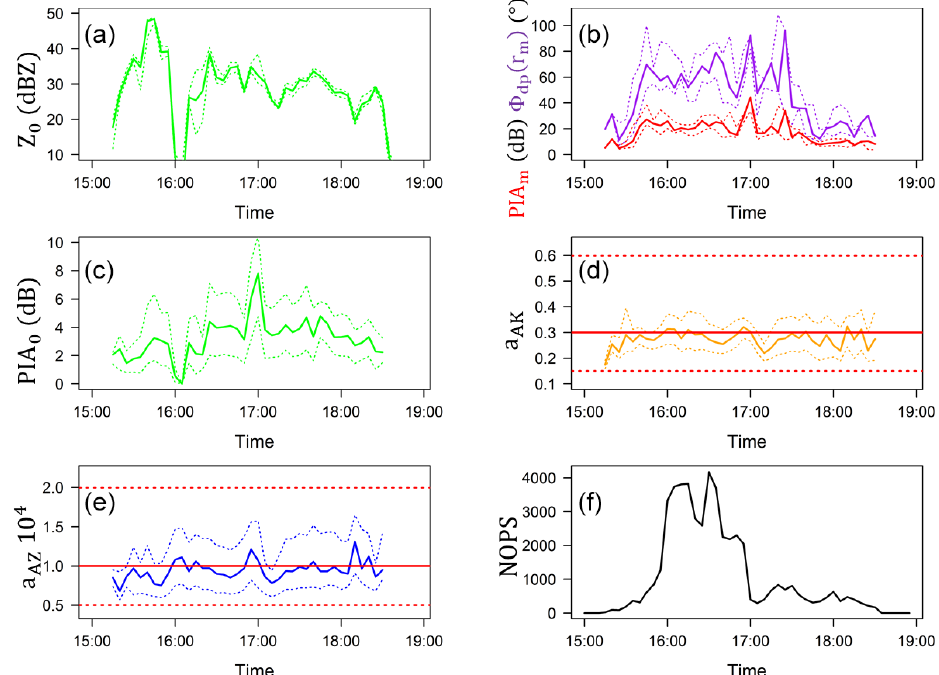
Figure 6. Time series of the input variables and optimal parameters for the best simulation obtained for the 21 July 2017 convective event. The optimal set of fixed parameters for this event is dC = 0.5dB, b AZ = 0 . 80 and b AK = 1 . 1. For each of the three considered input variables (a) Z 0 , (b) PIA m (red) and (cid:56) dp (r 0 r m ) (purple) are displayed the median (continuous line) and the 25% and 75% quantiles (dotted lines) of their distributions over the 22 mountain targets. A similar representation is proposed for the LHS optimal parameters (c) PIA 0 , (d) a AK and (e) a AZ , except that the distributions are established over all optimal parameters of all targets. In panels (d) and (e) , the dotted horizontal lines materialize the lower and upper limits consider in the LHS of the considered parameter. The time series of the number of optimal parameter sets (NOPSs) cumulated over all the 22 targets is displayed in panel (f) . Table 2. Some characteristics of the three convective events considered in this study. The melting layer (ML) detection was performed with the 25 ◦ elevation angle measurements of the XPORT radar, using the algorithm described in Khanal et al. (2019). The total rain amount and the maximum rain rate are recorded at the rain gauge available at the IGE site at the bottom of the Grenoble valley. The PIA m statistics are derived from the MRT by considering all the 22 mountain targets and the 0 ◦ elevation data of the Moucherotte mountain radar. Minimum Number of altitude of Maximum profiles with the ML Total rain rain rate in Maximum PIA m greater Beginning End bottom